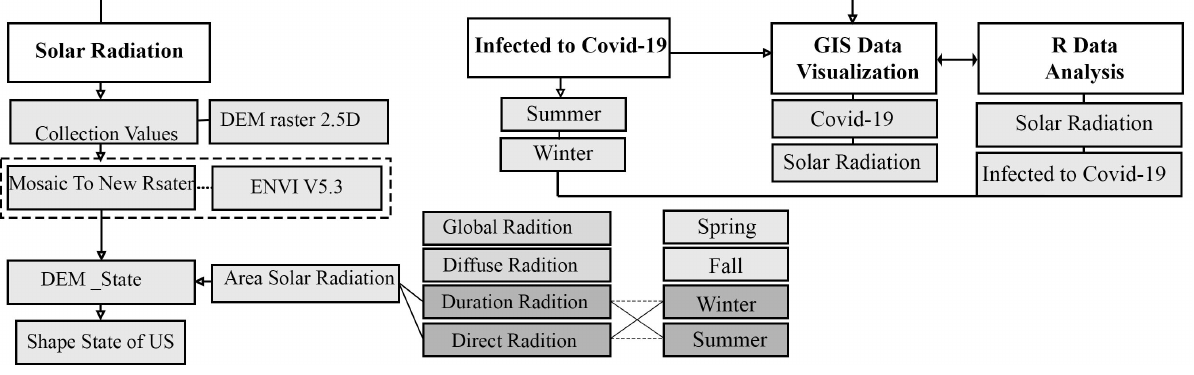
Figure 2. Research